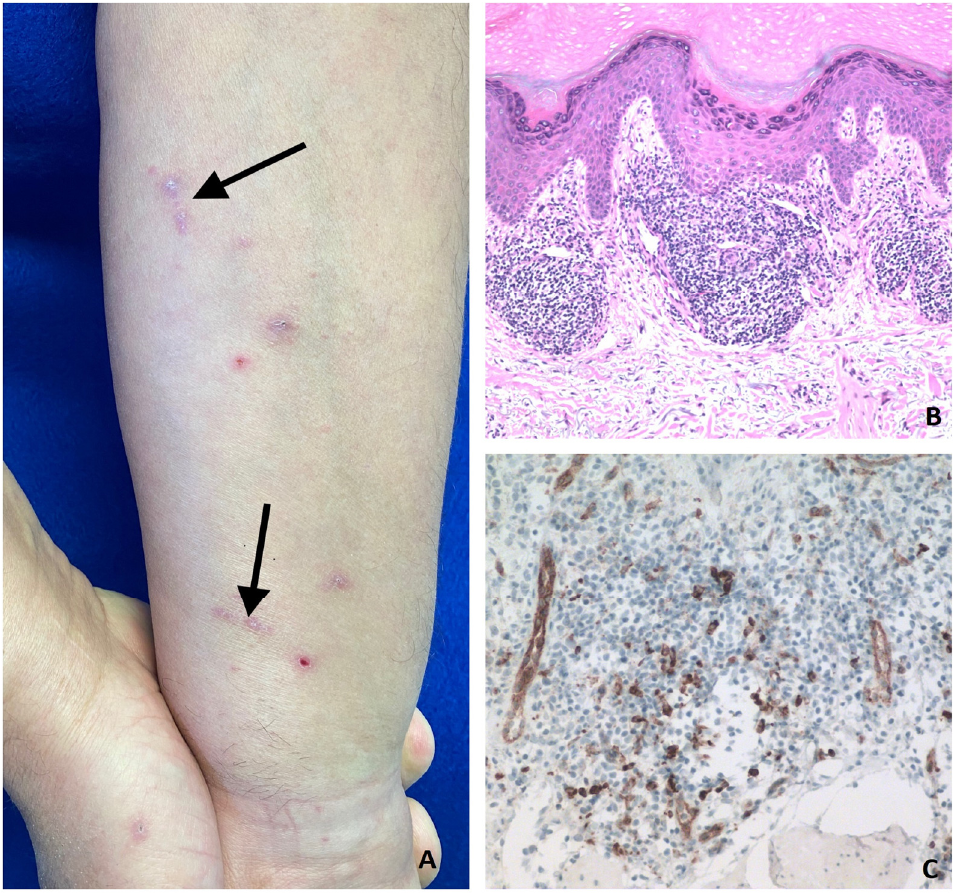
Figure 11. V-ILE Case 11. ( A ) Koebnerization, a linearly-distributed grouping of lesions precipitated by trauma (scratching in this case), is seen on the mid and distal flexural aspect of the left forearm (black arrows). Several excoriated papules are also shown. ( B ) Lichenoid dermatitis. Compact orthokeratosis, wedge-shaped hypergranulosis, acanthosis, foci of hydropic change and colloid bodies—features characteristic of typical lichen planus—are seen. The dermal lymphocytic infiltrate is focal and patchy with involvement of both the superficial and deep dermis. (Hematoxylin-eosin stain; Original magnification, ×100.) ( C ) Anti-human CD123 mouse monoclonal antibody revealed plasmacytoid dendritic cells in the dermis. These antigen-presenting cells, seen in the dermal infiltrates of inflammatory dermatoses, such as psoriasis, cutaneous lupus and lichen planus, are not seen in normal skin. Lighter staining of endothelial cells within venules is also seen. (Anti-CD123 immunoperoxidase; Original magnification, ×